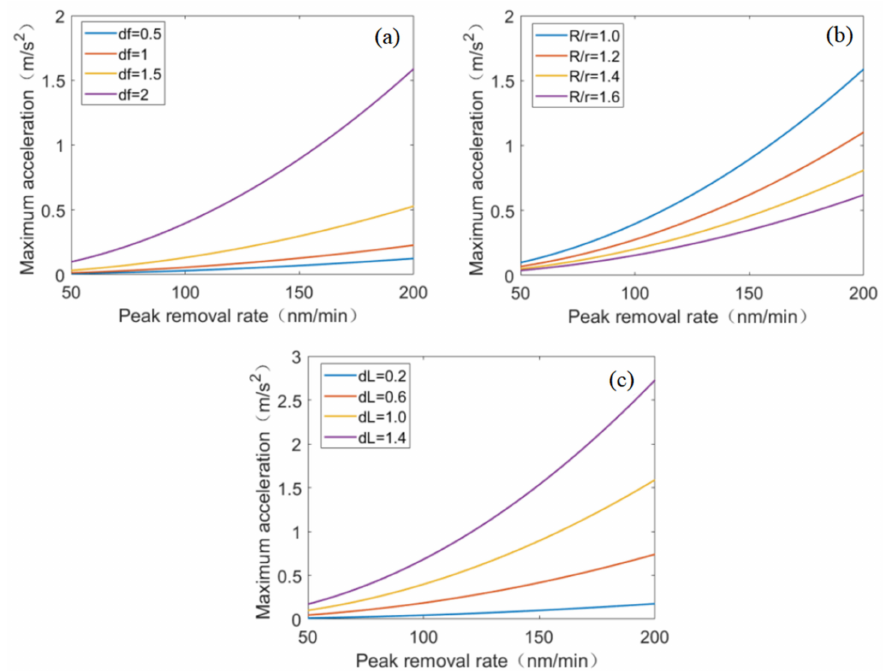
Figure 9. Dynamic performance requirement with the surface figure error frequency ( a ), the steepness of the surface ( b ), and the scanning spacing ( c